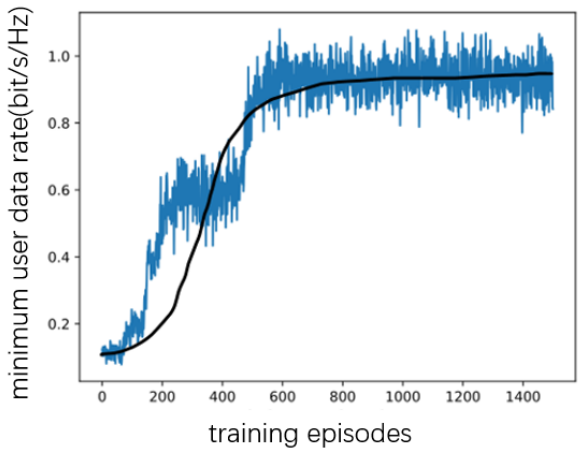
Figure 5. RIS = 40.